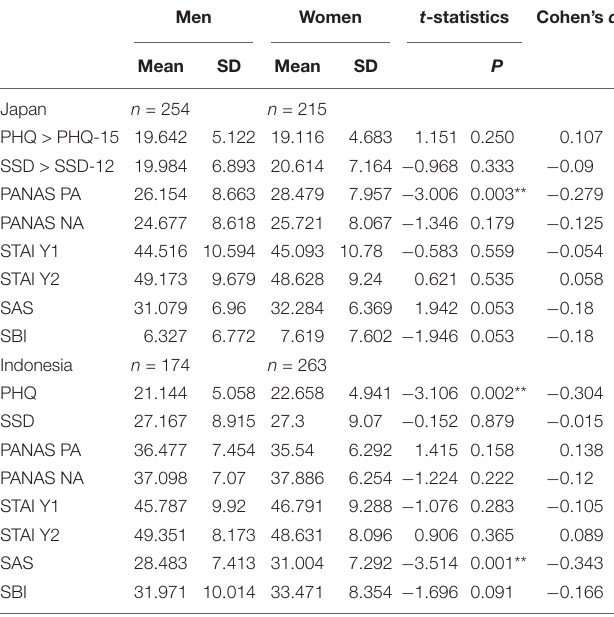
TABLE 2 | Comparison between men and women in the Japanese and Indonesian participants.